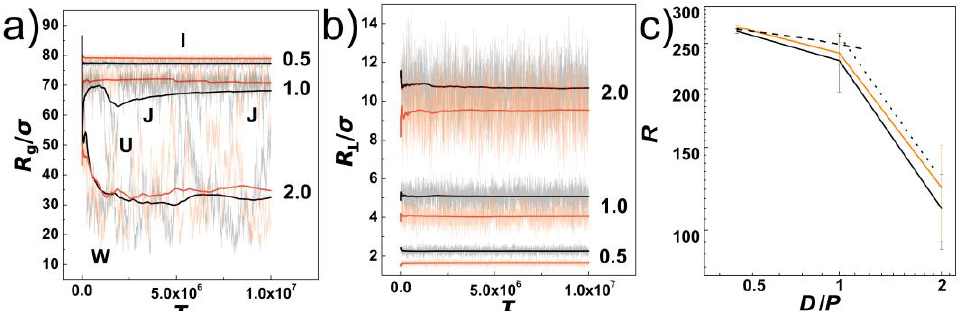
Figure 1. DNA confined in nano-channels without external compressive force. Data for cylindrical channels are shown in black and helical channels are in orange. The confinement strengths investi- gated are indicated by numbers D/P = 0.5, 1.0 and 2.0. Panels ( a , b ) show evolution of instantaneous values of gyration radius and transversal radius from the initial structure. The letters I, J, U, and W show impressions of DNA conformations. ( c ) average values of polymer span as a function of con- finement strength D / P . The dashed and dotted lines show theoretically predicted values.